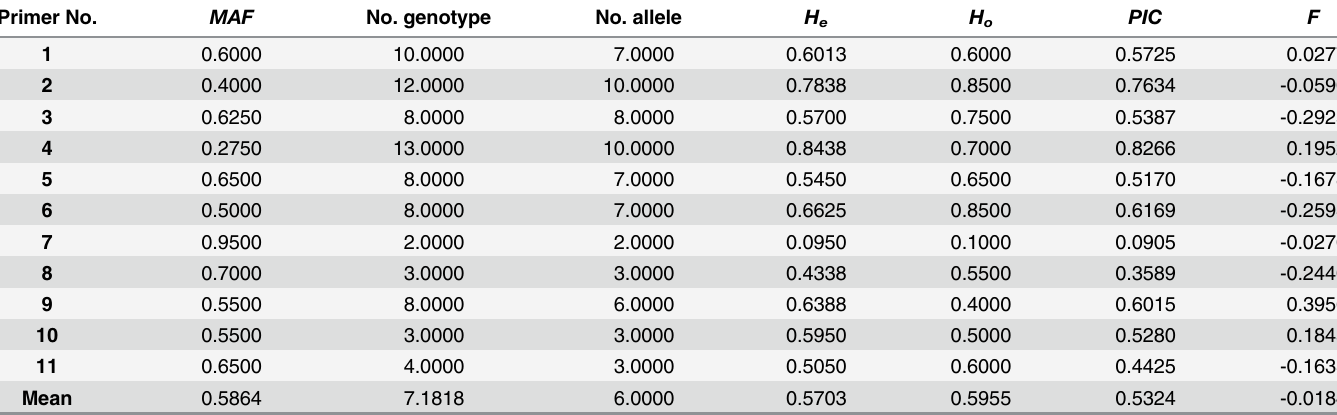
Table 3. Genetic diversity in the second-generation XX-OP selected population of Chinese pine. Primer